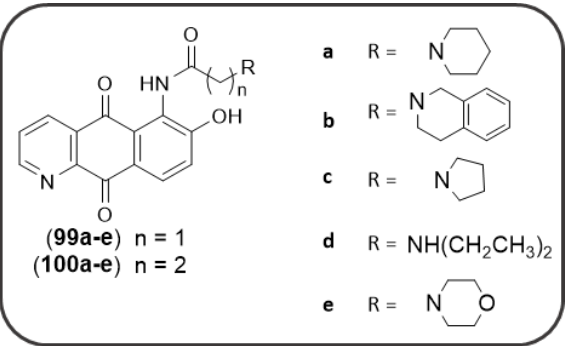
Figure 19. Wang, J. et al. synthetic azaanthraquinones as MTDLs.